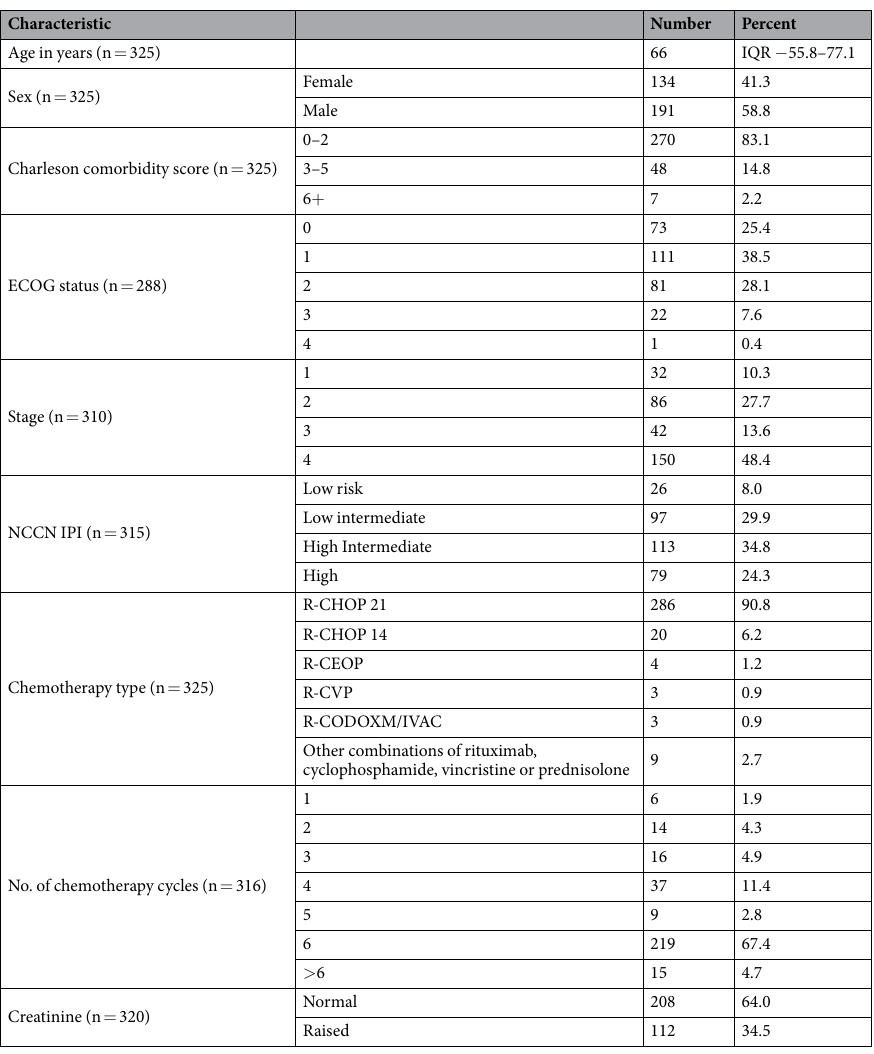
Table 1. DEMOGRAPHICS. ECOG = Eastern Cooperative Oncology Group performance status point scale. NCCN-IPI = International Prognostic Index. R-CHOP-21: rituximab, cyclophosphamide, doxorubicin, vincristine and prednisolone administered every 21 days. R-CHOP-14: rituximab, cyclophosphamide, doxorubicin, vincristine and prednisolone administered every 14 days. R-CEOP: rituximab, cyclophosphamide, etoposide, vincristine and prednisolone. R-CVP: rituximab, cyclophosphamide, vincristine and prednisolone. R-CODOXM/IVAC: rituximab, cyclophosphamide, doxorubicin, vincristine and prednisolone, cytarabine,